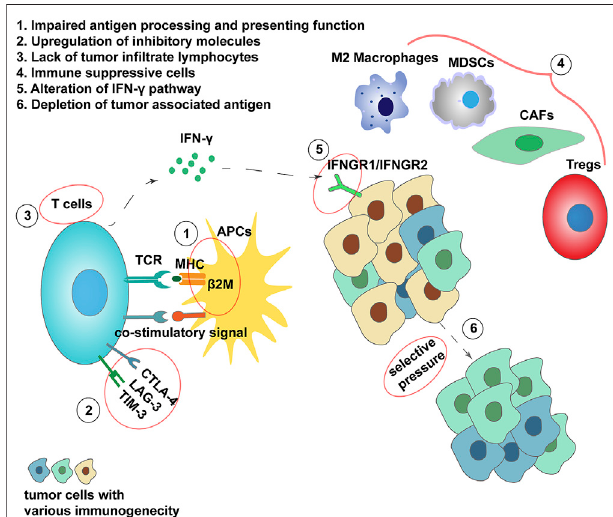
FIGURE 3 | Mechanisms of resistance from ICI treatment. 1) β 2M mutations lead to loss of HLA and antigen-presenting function. 2) Additional inhibitory signals expression. 3) Little tumor-in fi ltrating lymphocytes present in the tumor microenvironment resulting in nonresponse. 4) Immune suppressive cells in TME. 5) Loss of IFN- γ sensitivity. 6) Formation of low immunogenicity clone under selective